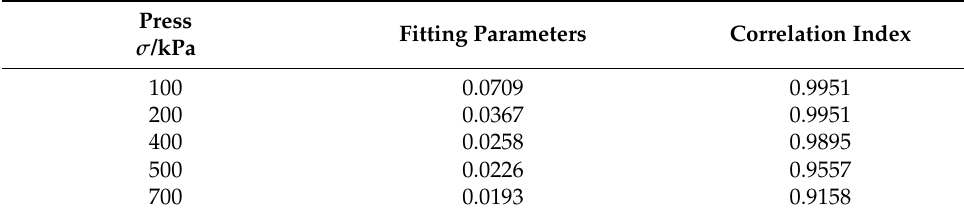
Table 7. Fitting parameters of lg ε -lg t relation of Changsha sandy soil.